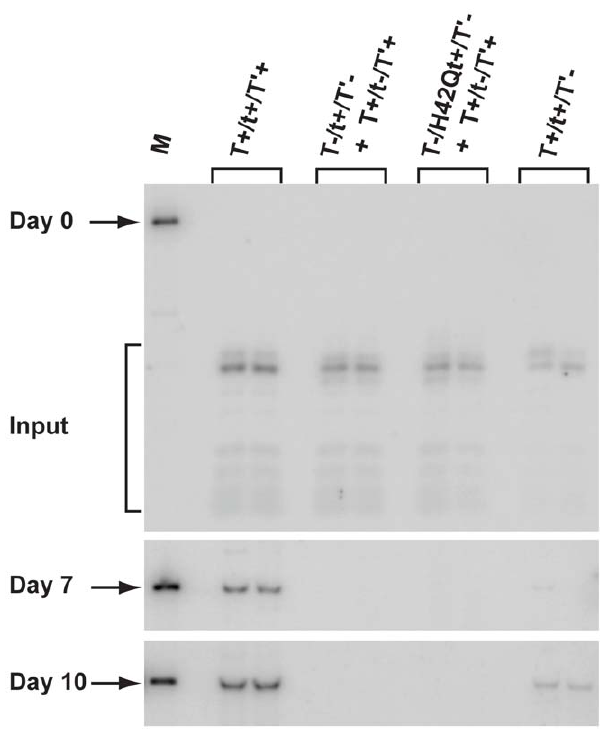
Figure 7. JCV tAg fails to complement replication of a tAg- deficient JCV genome in trans . PHFG cells in 60 mm plates were co- transfected in duplicate with 400 ng of a tAg-deficient (T + /t 2 /T’ + ) JCV genome and 400 ng of a JCV DNA construct expressing either wild type tAg (T 2 /t + /T 9 2 ) or a J domain mutant tAg (T 2 /H42Qt + /T 9 2 ) under the control of the JCV promoter-enhancer. Cells were also transfected with 400 ng of either a T 9 -deficient (T + /t + /T’ 2 ) JCV genome or a positive replication control (T + /t + /T’ + ). Duplicate, independent samples repre- senting each DNA construct were extracted by the method of Hirt [39] on days 0, 7, and 10 p.t. and analyzed using the Dpn1 assay as described in the legend to Figure 5. The marker shown in the first lane of each blot is 1 ng of linear JCV DNA (5130 bp), and the position of Dpn 1-resistent replicating genomes is denoted by an arrow at days 7 and 10 p.t. Dpn 1- and Eco RI-sensitive input DNAs are noted at the day